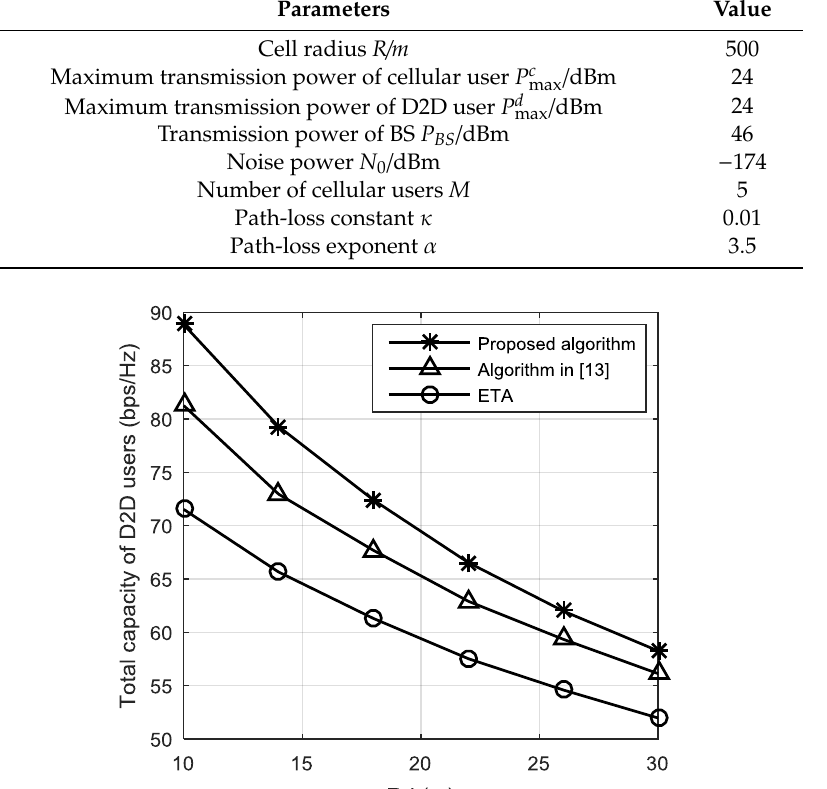
Figure 4. Total capacity of D2D users with different number of D2D users.